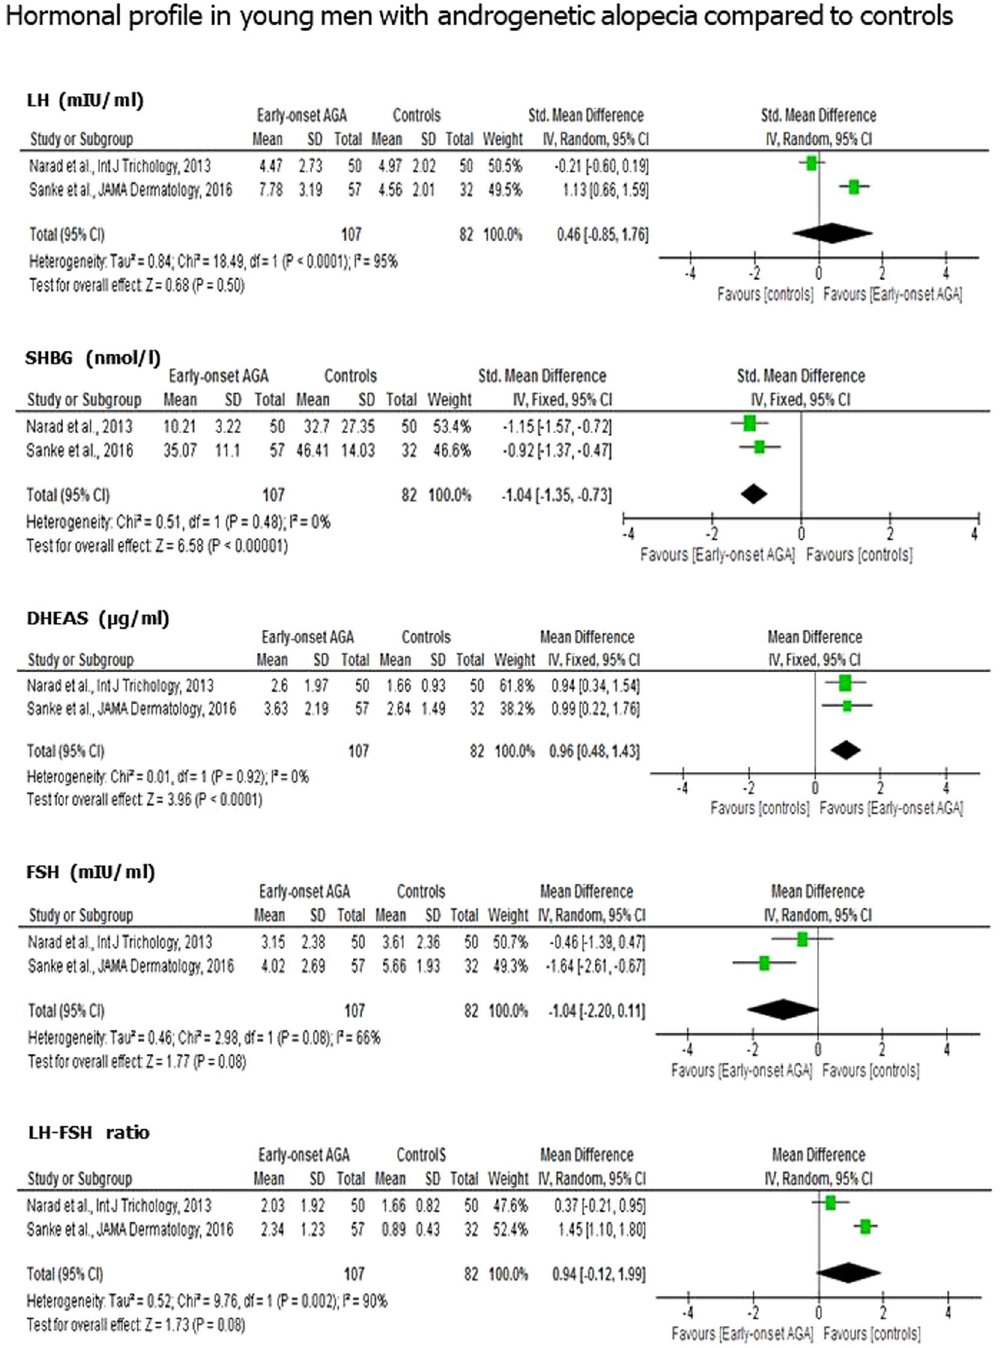
Figure 4. Hormonal profile in young men with androgenetic alopecia compared to controls. Men with early- onset androgenetic alopecia younger than thirty-five years old showed significantly higher luteinizing hormone (LH) and dehydroepiandrosterone sulphate (DHEAS), and lower sex hormone binding globulin (SHBG) serum levels compared to controls. A downward trend for serum follicle-stimulating hormone (FSH) and an upward trend for the LH/FSH ratio was found. No difference in testosterone levels was observed among the two groups. Both LH and FSH were expressed in mIU/ml, DHEAS in µ g/ml, SHBG in nmol/l, total testosterone in